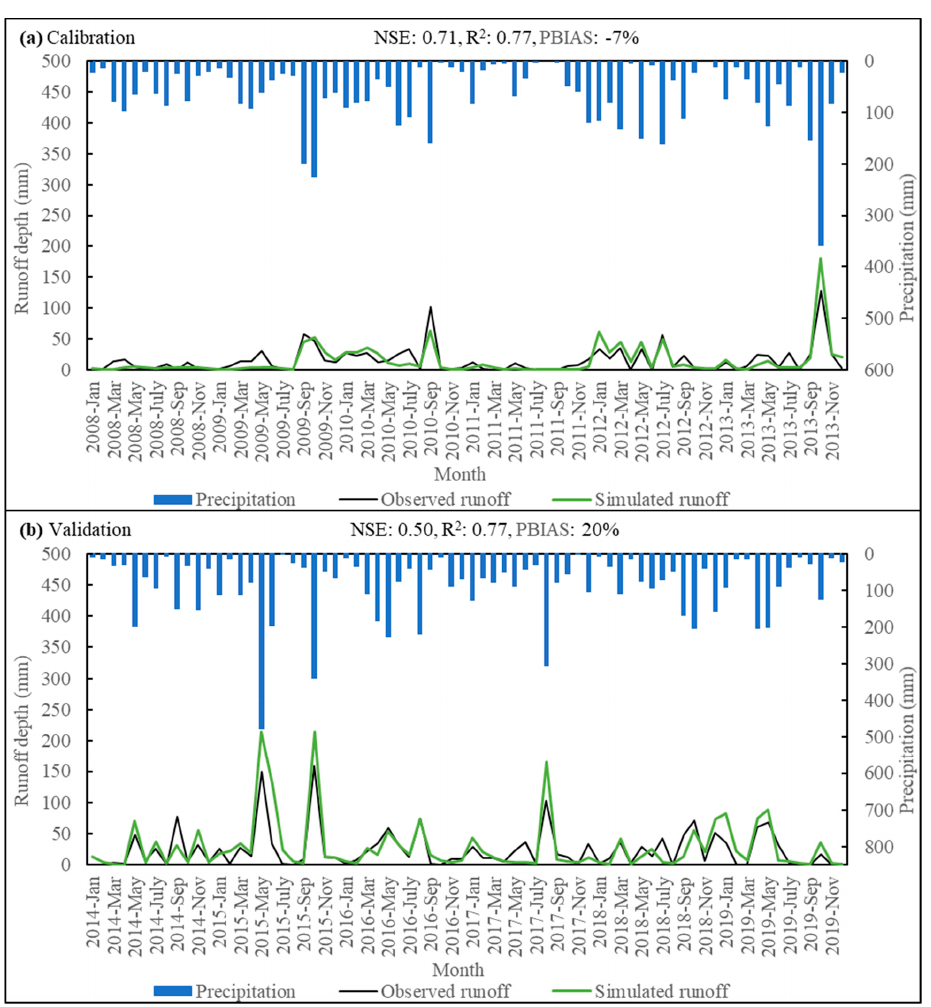
Figure 3. The simulated and observed runoff depths at the watershed outlet during the model calibration ( a ) and valida ‐ tion ( b ) periods.